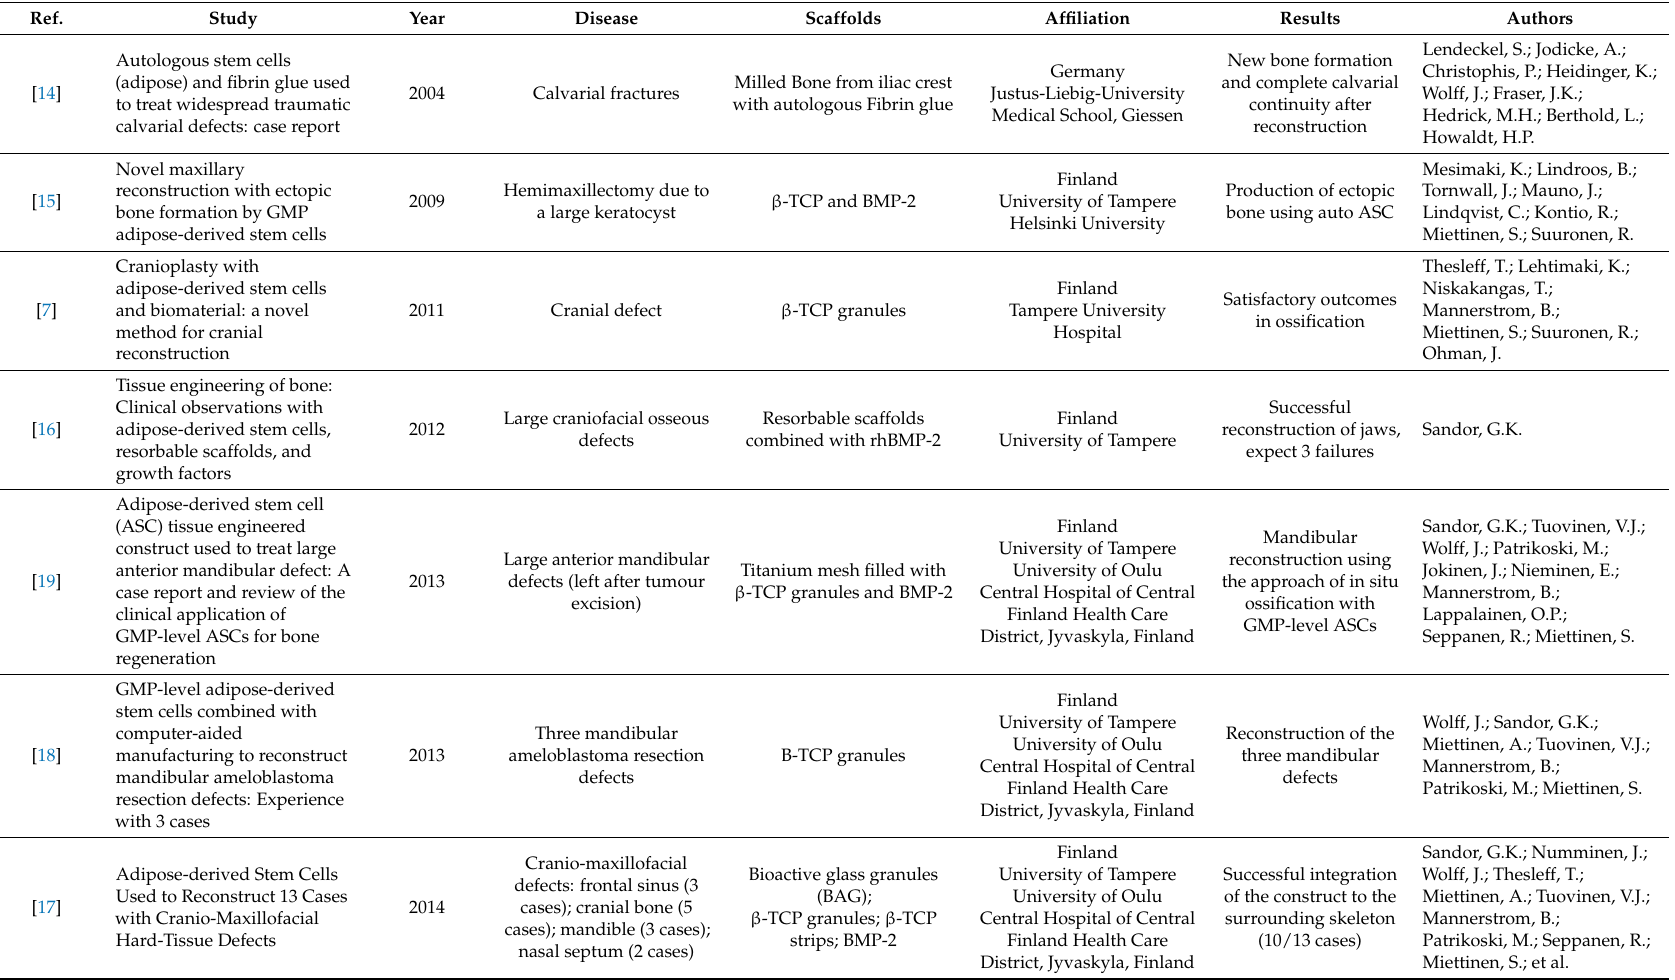
Table 1. Published Case Reports Using adipose-derived stromal/stem cells (ASCs) in Craniomaxillofacial Bone Regeneration.